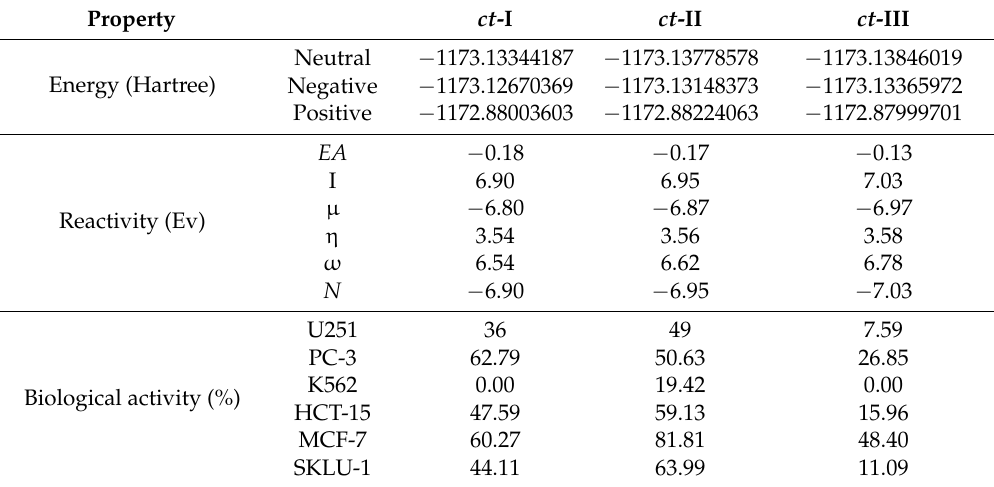
Table 9. Reactivity properties of objective molecules and the corresponding relationship with their biological